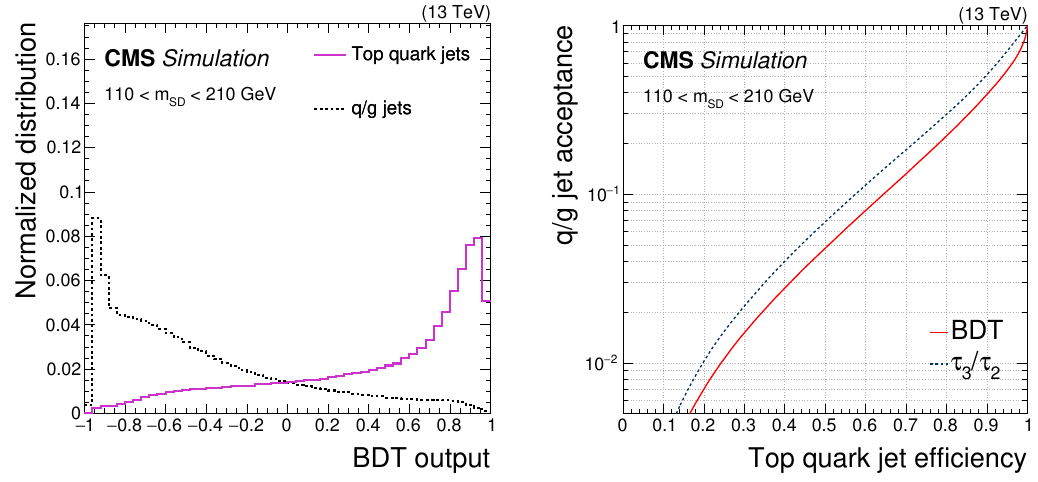
Figure 2 . Performance of BDT tagging of top quark and q/g jets. The left (cid:12)gure shows the BDT output in both types of jets. The right (cid:12)gure shows the rate of misidentifying a q/g jet as a function of the e(cid:14)ciency of selecting top jets. In both (cid:12)gures, the p T spectra of jets are weighted to be uniform, and the m SD is required to be in the range of 110{210